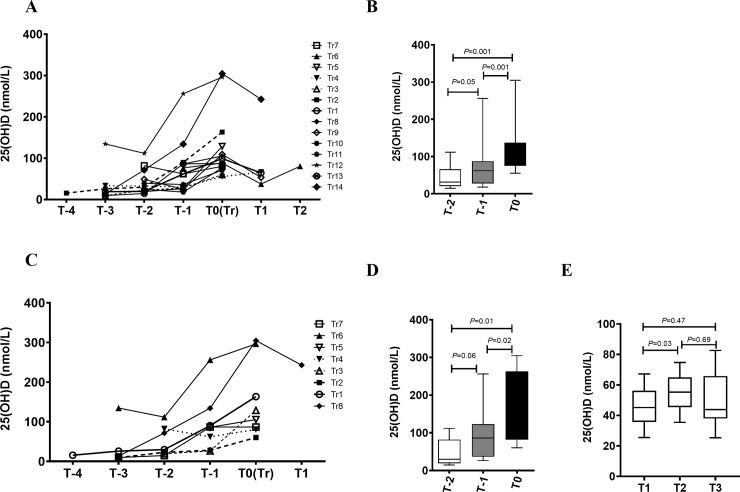
Longitudinal analysis of 25(OH)D levels in progressors.(A) Line graph showing the evolution of 25(OH)D levels over time in progressors (N = 14) prior to RA onset (T-1 to T-4), at the time of clinical diagnosis of RA onset (T0) and post-onset (T1 and T2) (B) Box-Whiskers plot showing the distribution of 25(OH)D at two time points prior to RA onset (T-1 and T-2) and at transition point (0). Data was analyzed by repeated measures ANOVA using Greenhouse-Geisser model (C) After correcting for storage effect, line graph showing the evolution of 25(OH)D levels over-time in progressors (N = 8) prior to RA onset (T-1 to T-4), at the time of clinical diagnosis of RA onset (T0) and post-onset (T1 and T2). (D) Box-Whiskers plot showing the distribution of 25(OH)D at two time points prior to RA onset (T-1 and T-2) and at transition point (T0), in samples collected after 2013. (E) Box-Whiskers plot showing the distribution of 25(OH)D in ACPA-/FDR collected at 3 different time points. Data was analyzed by repeated measures ANOVA with Geisser-Greenhouse correction.